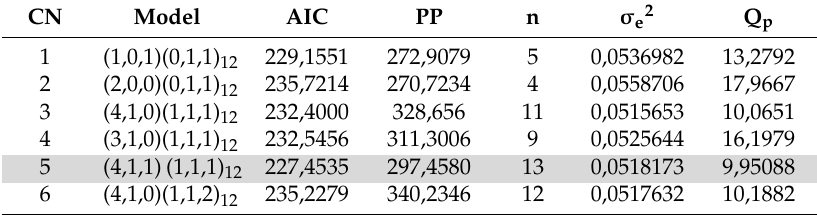
Table 3. Number of parameters (n), residual variance ( σ e2 ) Akaike Information Criterion (AIC), and Portmanteau test (Q p ) of the logarithmic-transformed time series data of monthly discharge at Kefalovriso spring